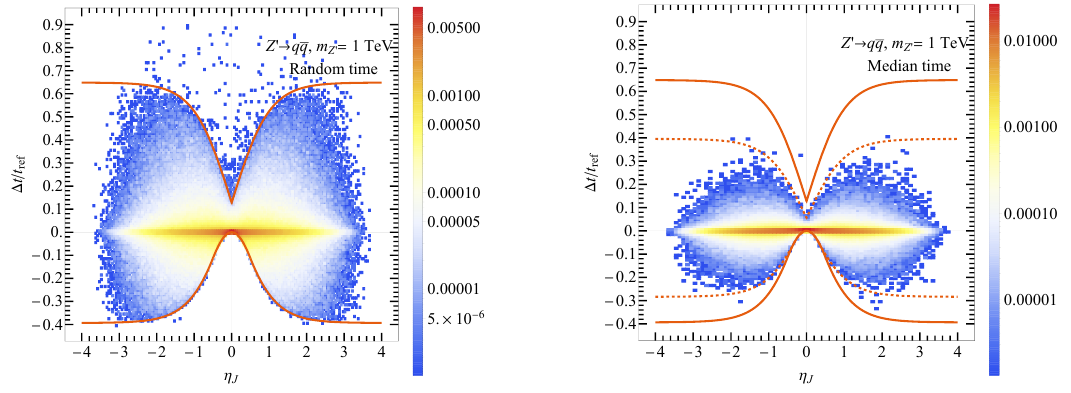
Figure 9 . The relative time difference vs. η J distribution for random time (left) and median time (right). The solid red curves depict the bounds from eqs. (3.7) and (3.8). The dashed red curve depicts the same bounds for a jet of radius (2 / 3) R